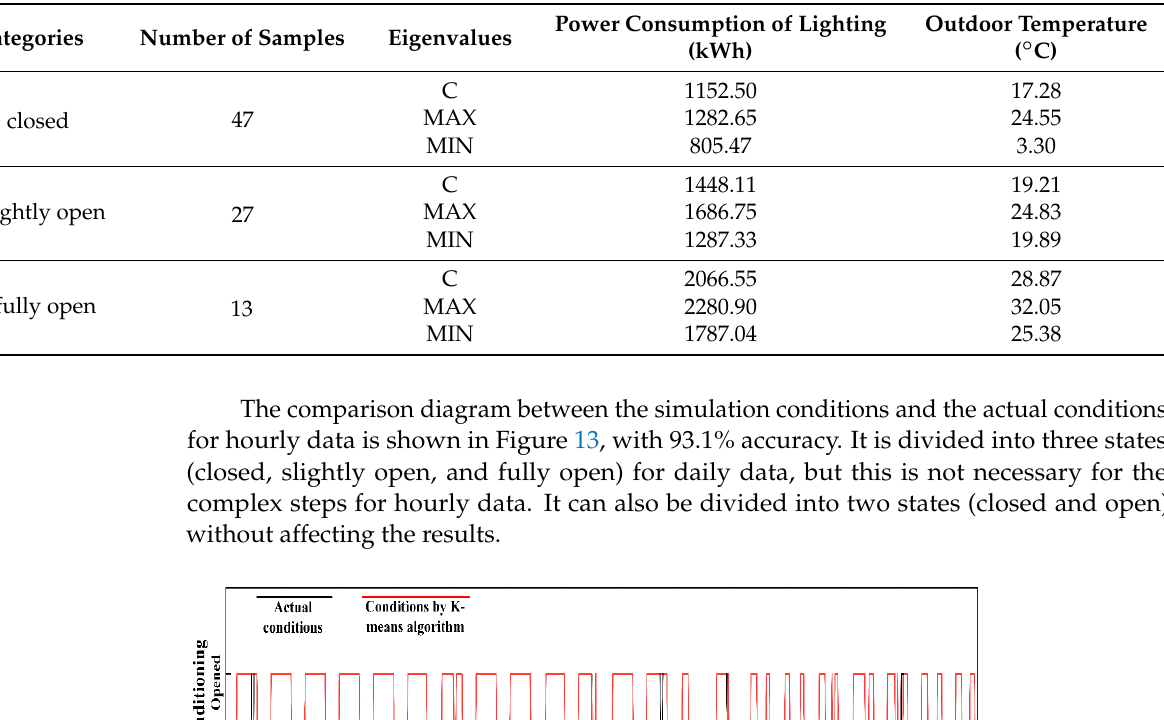
Figure 12. Characteristic value recognition results. Figure 15. Characteristic value recognition results. Table 5. Eigenvalues of three clusters by the KNN method. Table 5. Eigenvalues of three clusters by the KNN method.